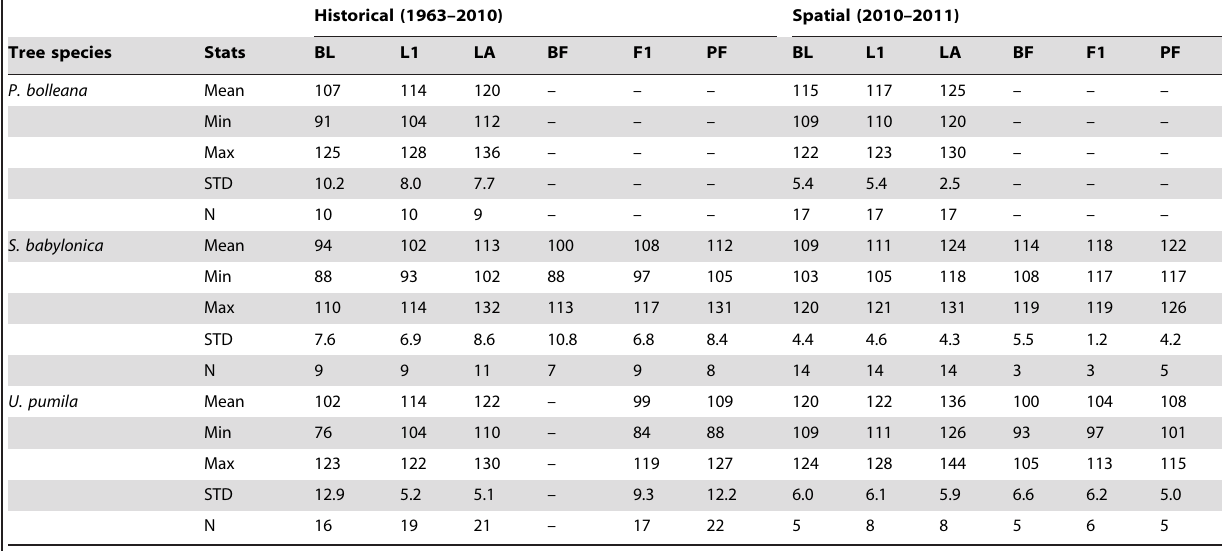
Table 1. Phenology basic